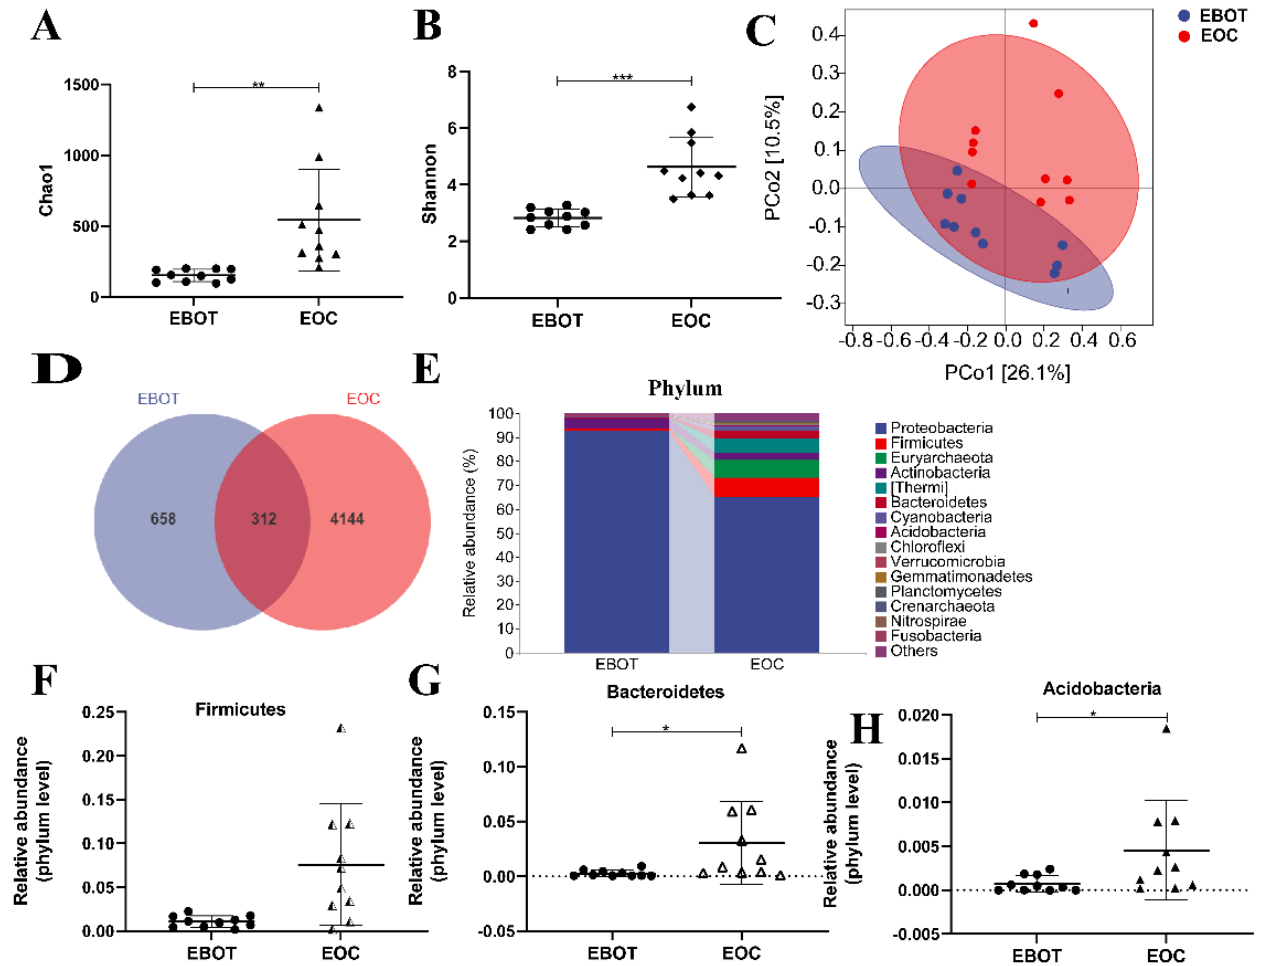
Figure 1. The microbial composition of EBOT and EOC tissues is distinct. ( A ) The Chao1 index. ( B ) The Shannon index. ( C ) PCoA of the weighted UniFrac distance demonstrated that the EBOT and EOC tissues showed two distinct clusters. ( D ) Venn map representation of OTUs. ( E ) Microbial composition in epithelial ovarian tumours at the phylum level. The relative abundance of ( F ) Firmicutes, ( G ) Bacteroidetes, and ( H ) Acidobacteria were analysed. Data are presented as means ± SD; * p < 0.05, ** p < 0.01, *** p < 0.001.